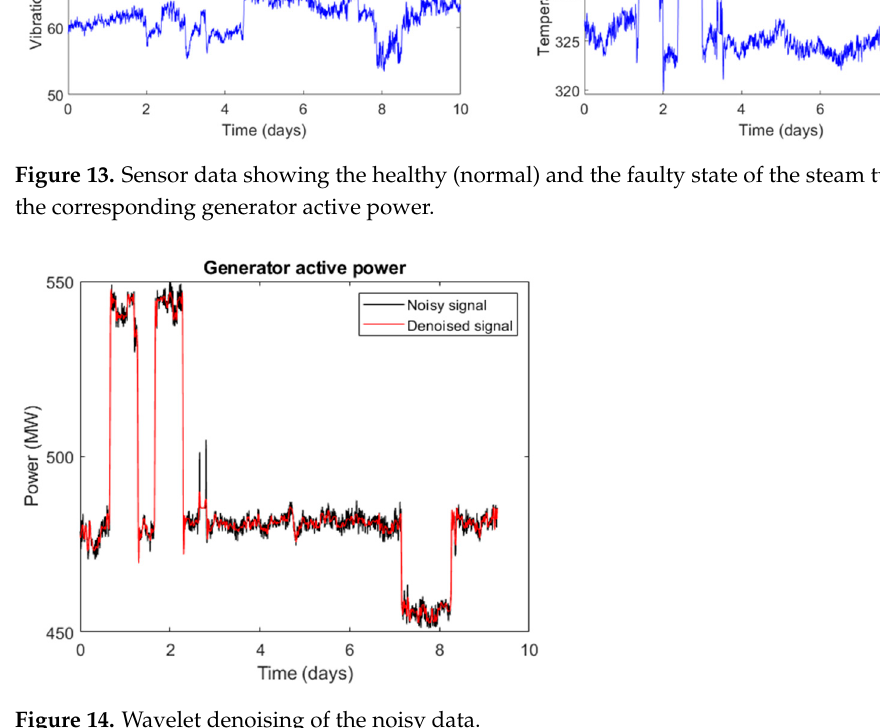
Figure 13. Sensor data showing the healthy (normal) and the faulty state of the steam turbine with the corresponding generator active power.